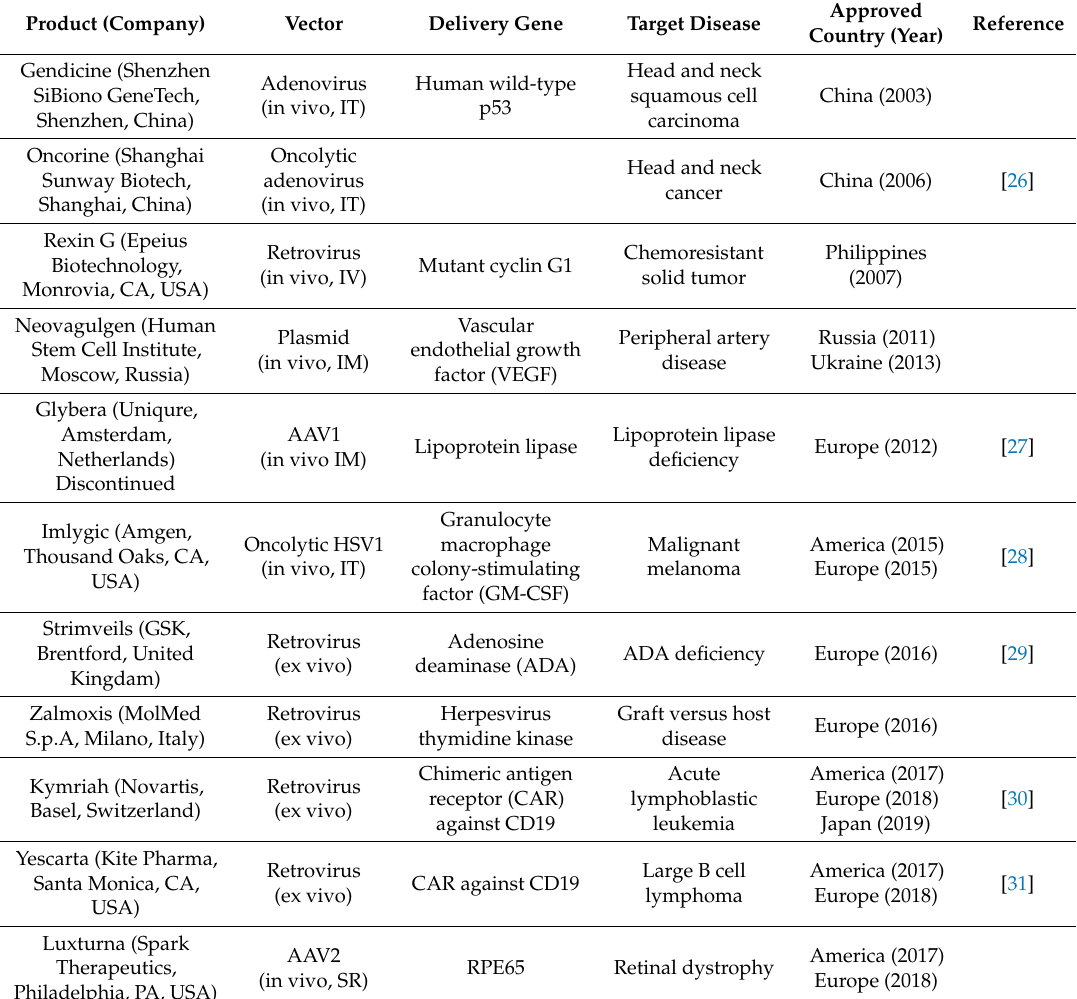
Table 1. Gene therapy products launched around the